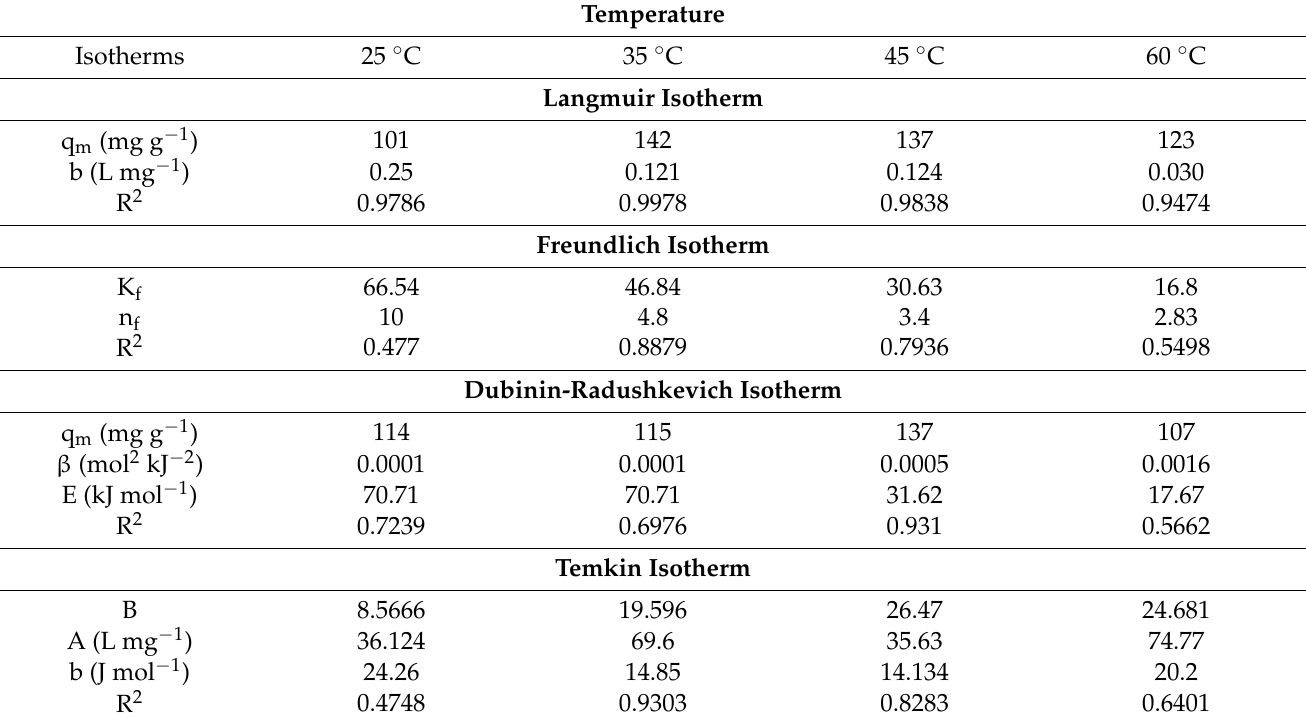
Table 2. List of calculated parameters from the adsorption isotherm